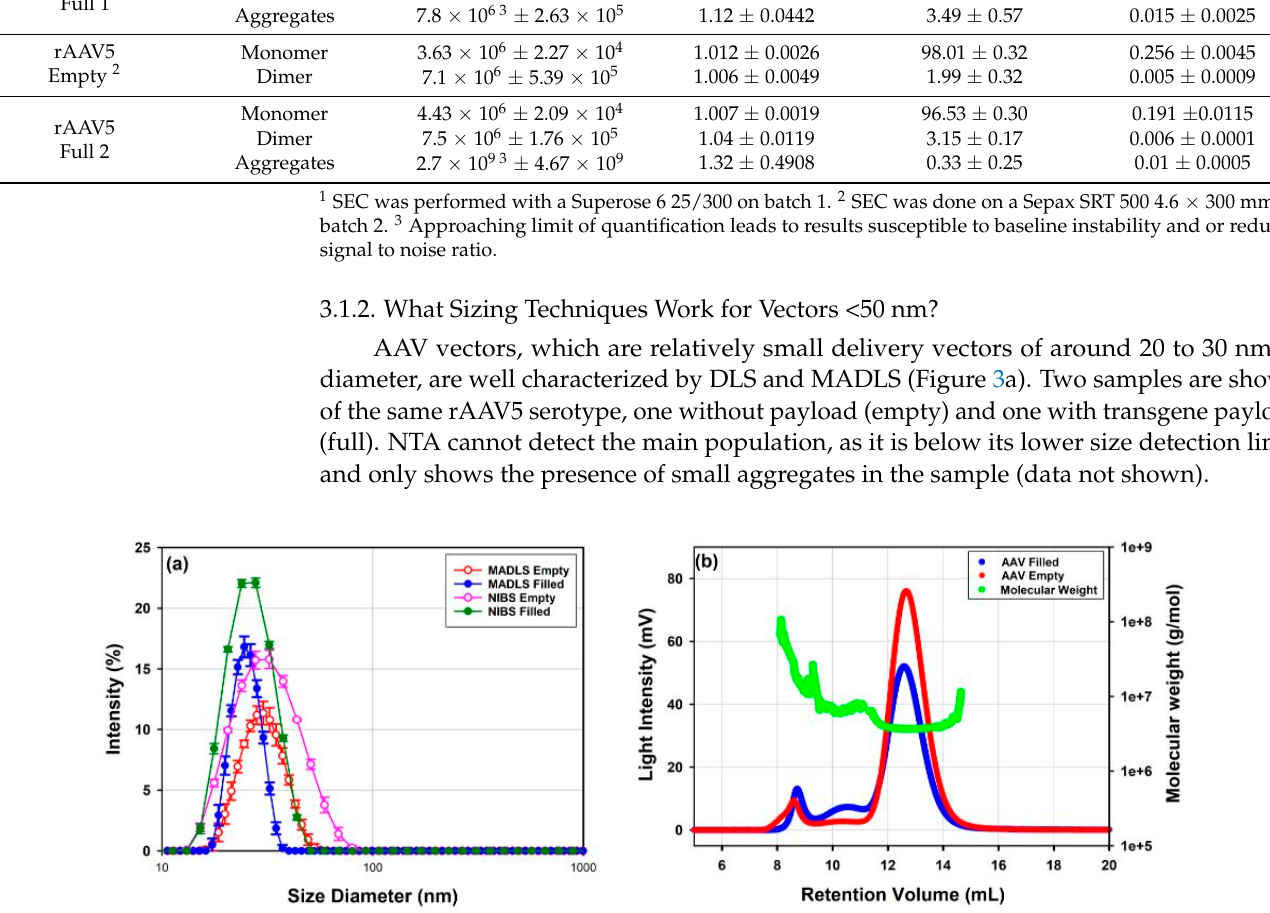
Figure 3. ( a ) Non-invasive backscatter DLS and MADLS intensity PSDs of rAAV5 samples batch 1 that are either full or empty. ( b ) shows how SEC separation of the same samples ahead of static light scattering detectors increases size distribution resolution compared to MADLS.